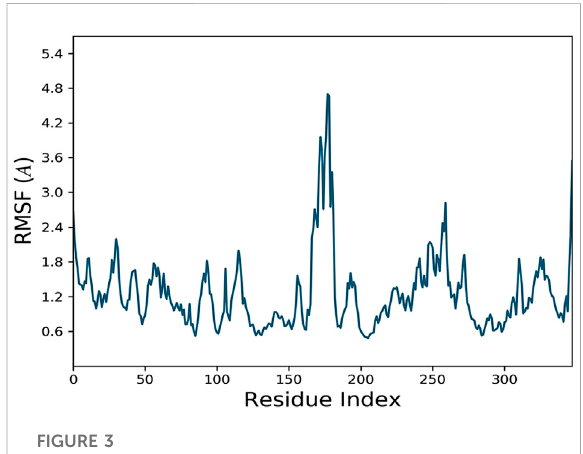
FIGURE 3 Represents root mean square fl uctuation (RMSF) of mitogen- activated protein kinase (MAPK, PDB I.D: 5UOJ) obtained through Desmond software